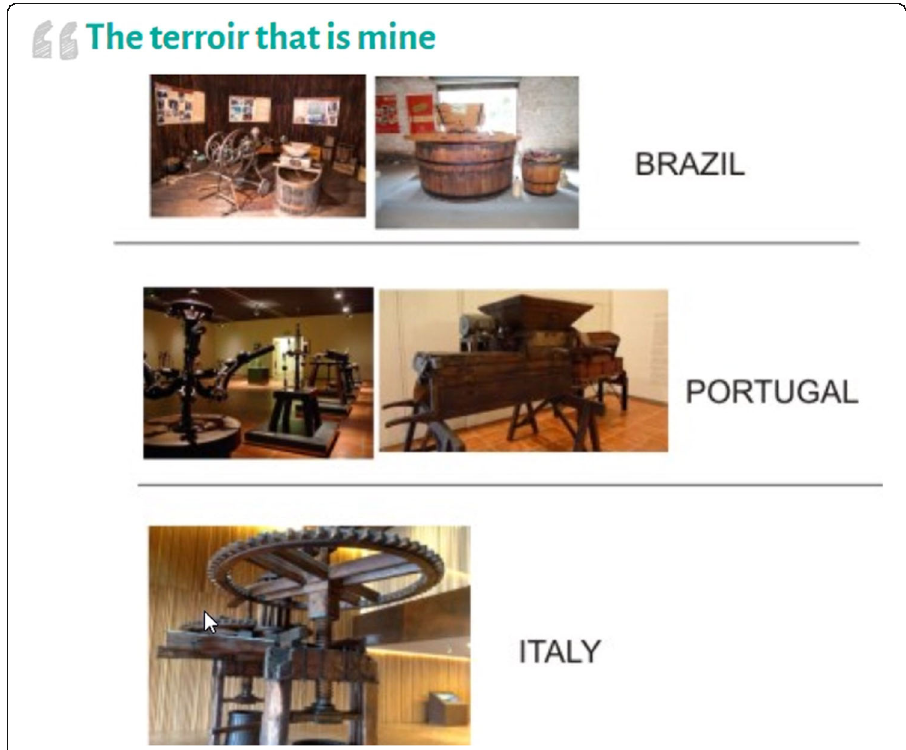
Fig. 15 An example of a learner ’ s post of region-specific